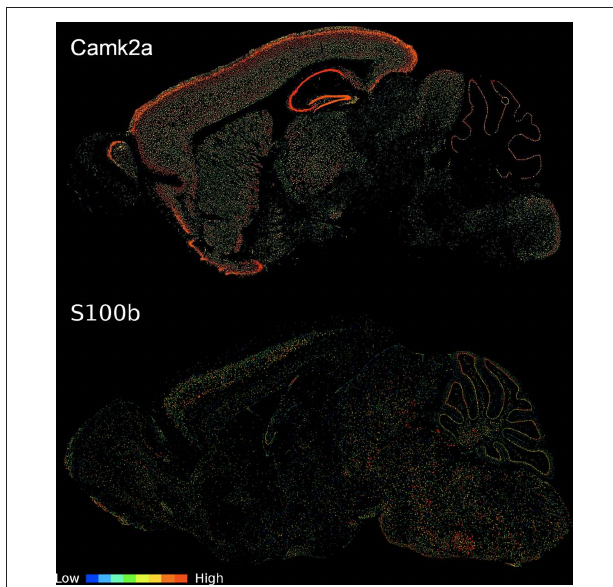
Figure 2 | Sagittal expression energy images of a pattern Ne and Oe gene. CamK2a displays pattern NE (image series 79360274) and S100b shows pattern OE (image series 924). Images were downloaded from the ABA web site (http://www.brain-map.org). While all expression information for the analysis is from coronal assays, we selected a sagittal view to better show interregional variability in a